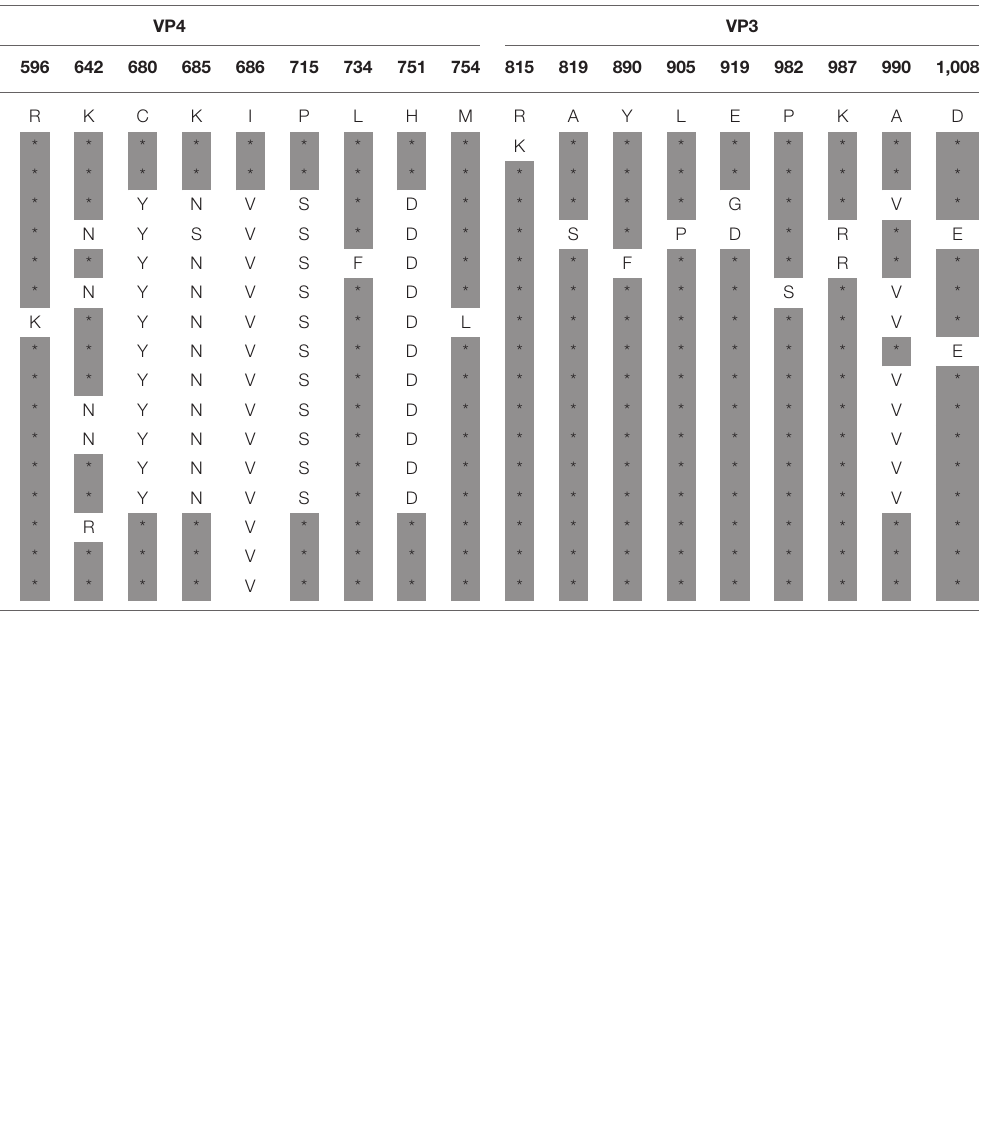
TABLE 4 | Amino acid substitutions in the polyprotein of the study IBDV (excluding HVR) in comparison to reference strains. Strain